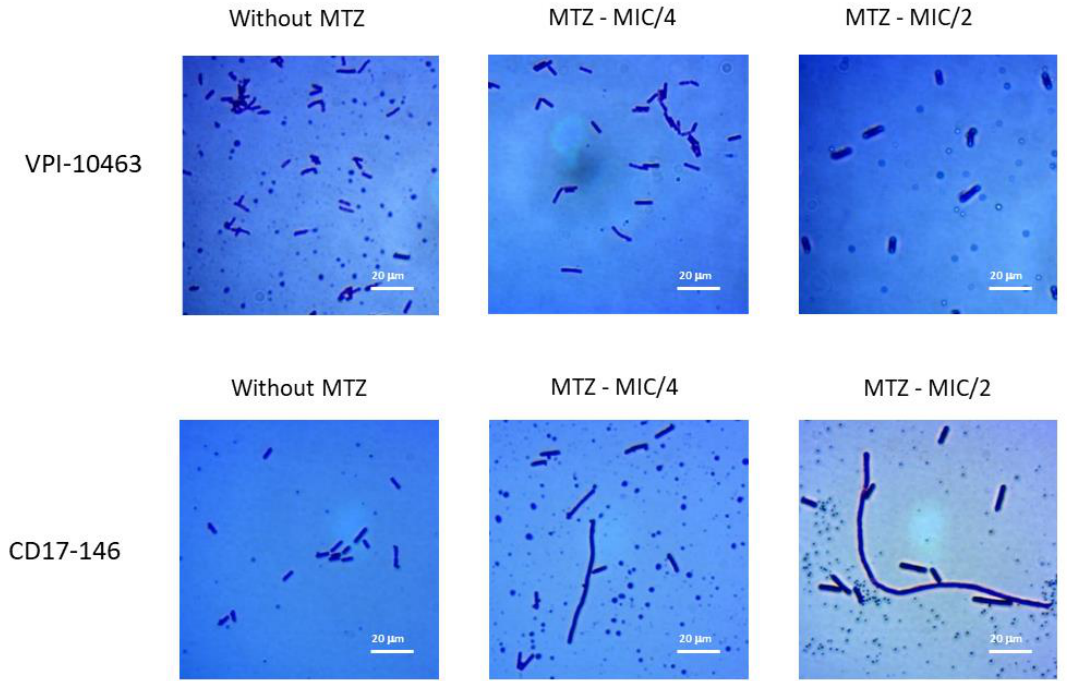
Figure 1. Morphology of bacterial cells at subinhibitory concentrations of MTZ. VPI 10463 and CD17-146 were grown in BHI-SG broth without MTZ or with MTZ at MIC/4 and MIC/2 until OD600 nm of cultures reached 0.4. Gram-stain images of CD17-146 at 100× magnification demonstrated an elongation of bacterial cells.